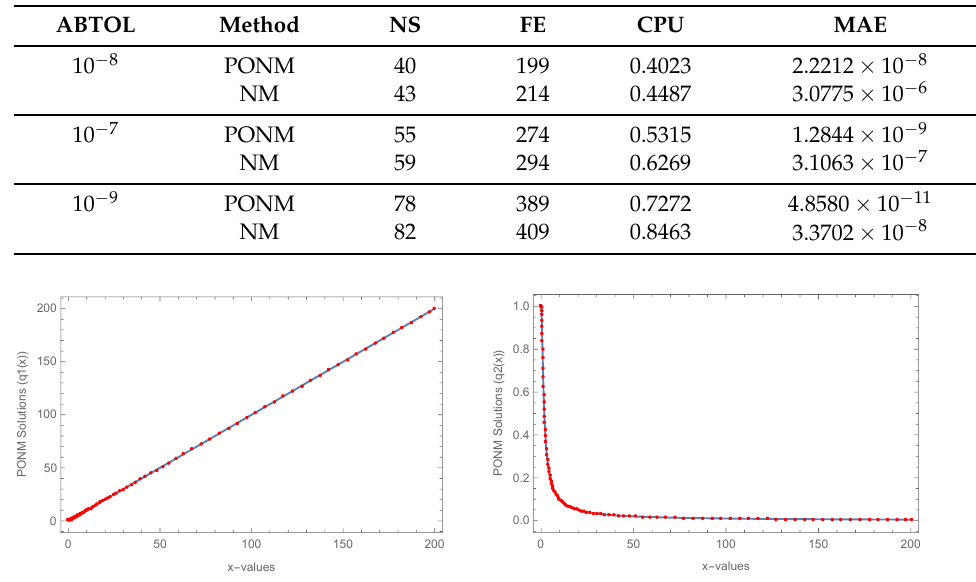
Table 5. Numerical results on (8) with h 0 = 10 − 3 , x ∈ [ 0,100 ] .